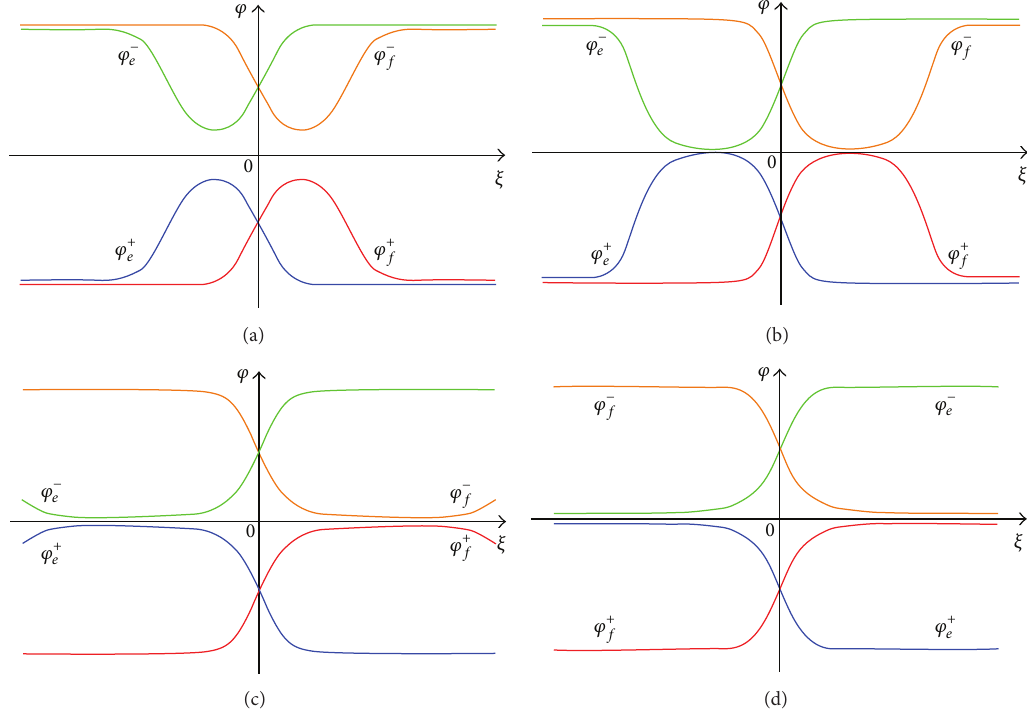
Figure 10: (The four low-kink waves are bifurcated from the four antisymmetric solitary waves.) The varying process for the figures of 𝜑 ± 𝑒 and 𝜑 ± 𝑓 when 𝜇 > 0, 𝜇 ̸= |𝜇 0 |, (𝑞,𝑝) ∈ 𝐴 4 , and 𝑝 → 3𝑞 2 /16𝑟+0 , where 𝑟 = 1 , 𝑞 = −4, 𝑙 2 : 𝑝 = 3𝑞 2 /16𝑟 = 3, and 𝜇 = 4 and (a) 𝑝 = 3+10 −1 , (b) 𝑝 = 3 + 10 −3 , (c) 𝑝 = 3 + 10 −5 , and (d) 𝑝 = 3 + 10 −7